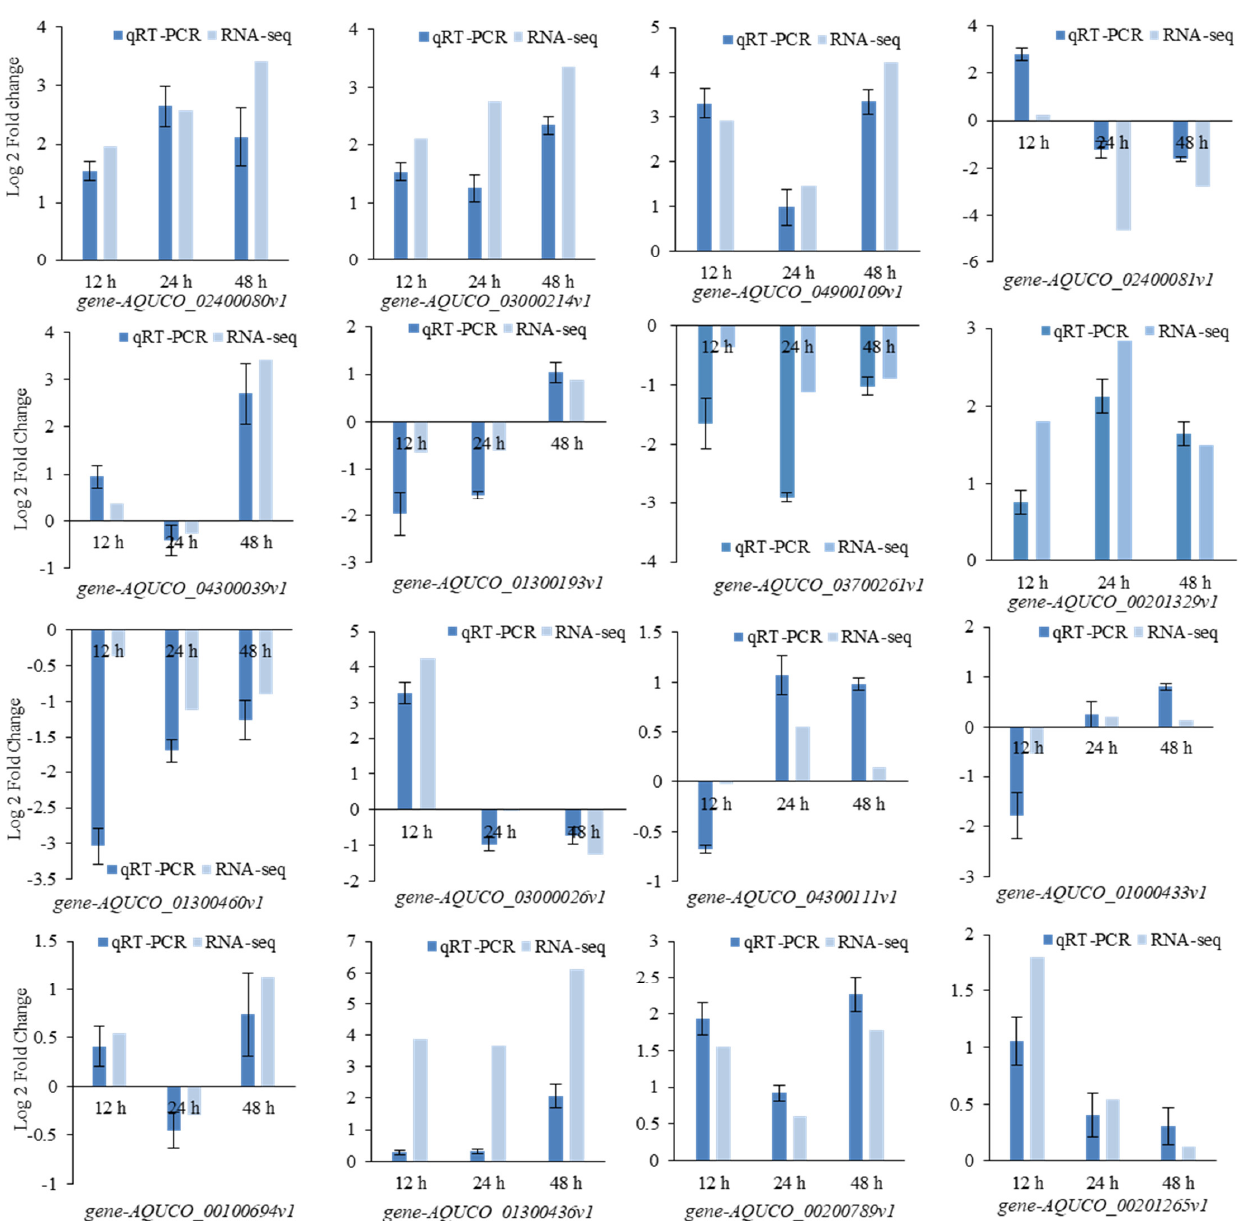
Figure 9. Log 2-fold changes of 16 genes in quantitative real-time PCR (qRT-PCR) and